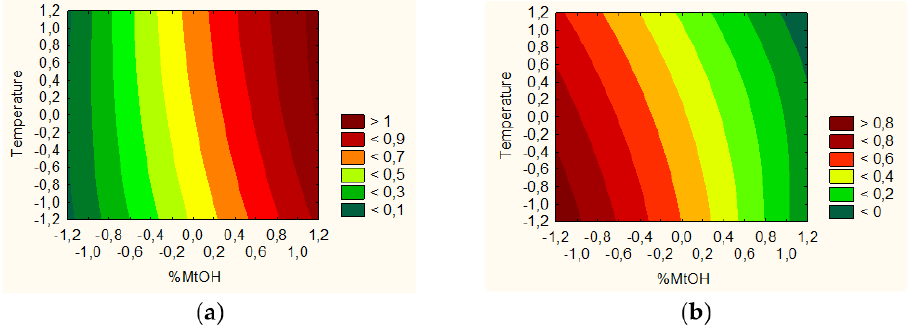
Figure 4. Model utility contour profiles for effect with a positive sign ( a ) baicalin content and TPC, and negative sign ( b ) antioxidant and anti-hyaluronidase